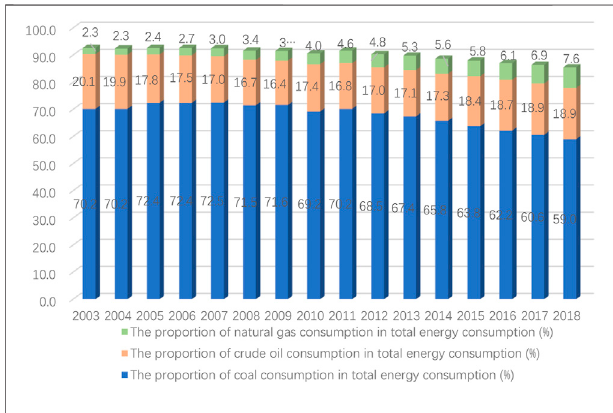
FIGURE 2 | The percentage of China ’ s energy consumption (2003 – 2018). Data Sources: China Statistical Yearbook 2004 –